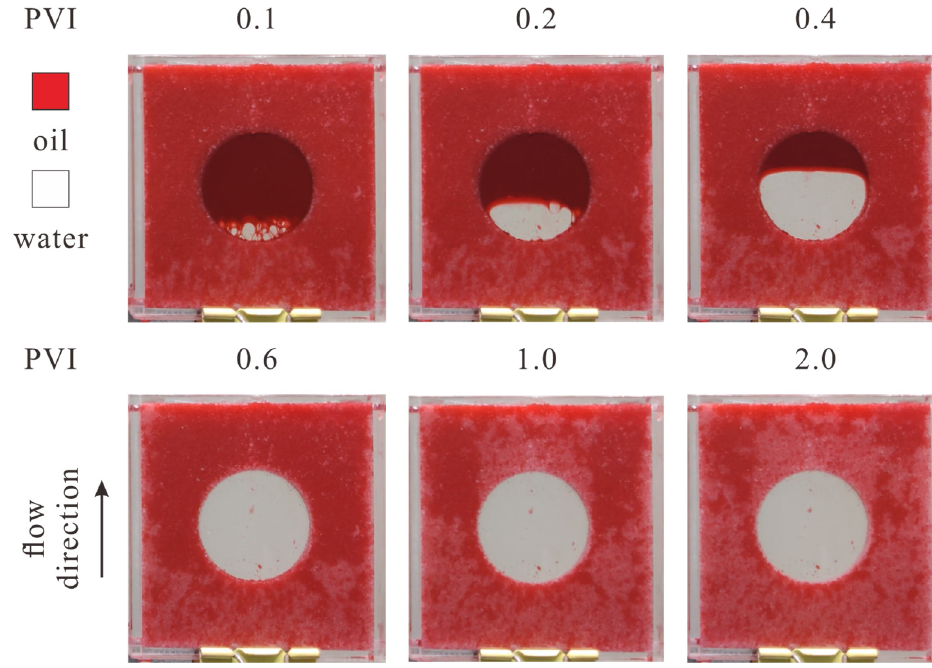
Figure 6. Oil saturation distribution in the single-vug model during experiments with θ = 90°.